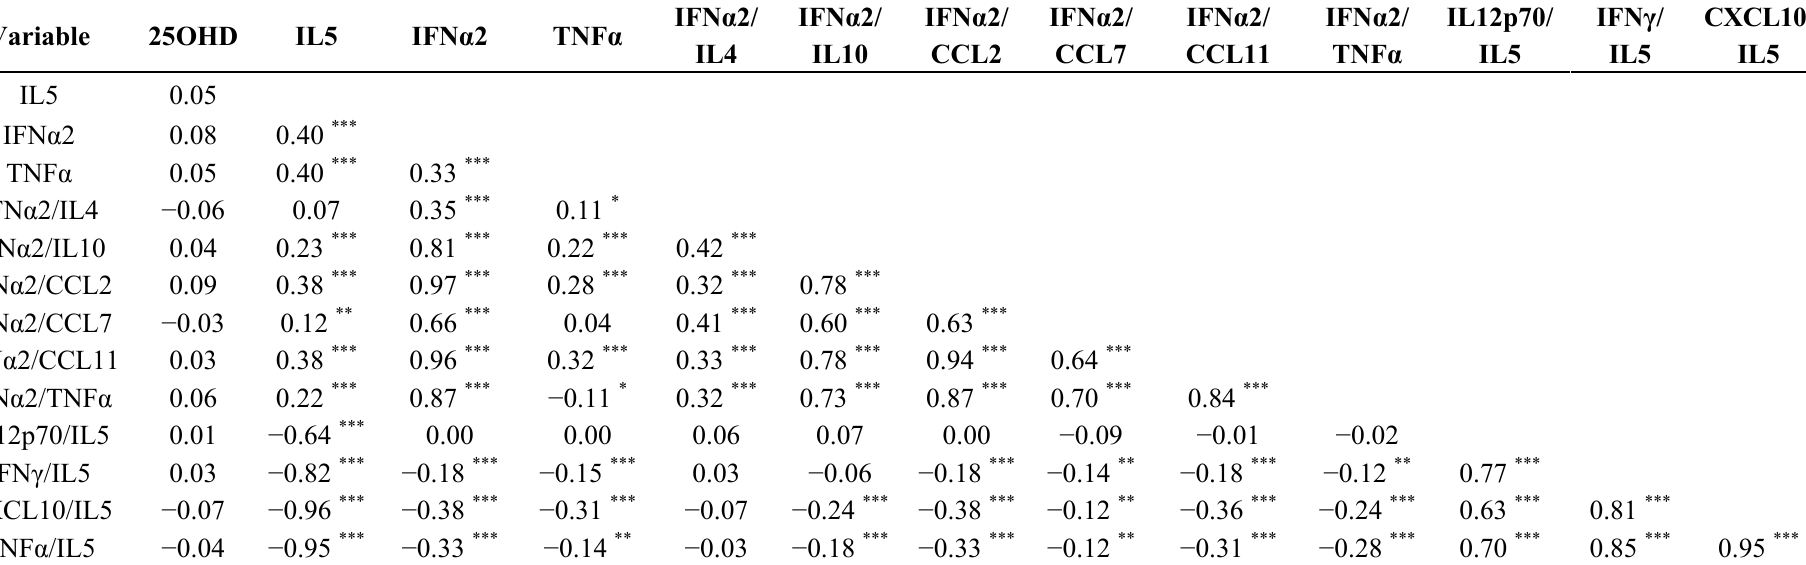
Partial correlations adjusted for age at diagnosis, season, date of blood draw, timing of blood draw in relation to surgery and treatment, and tumor stage. *, p < 0.05; **, p < 0.01; ***, p < 0.001. Table 3. Associations of blood levels of 25OHD and cytokines with odds of estrogen receptor (ER) negative breast cancer versus ER positive breast